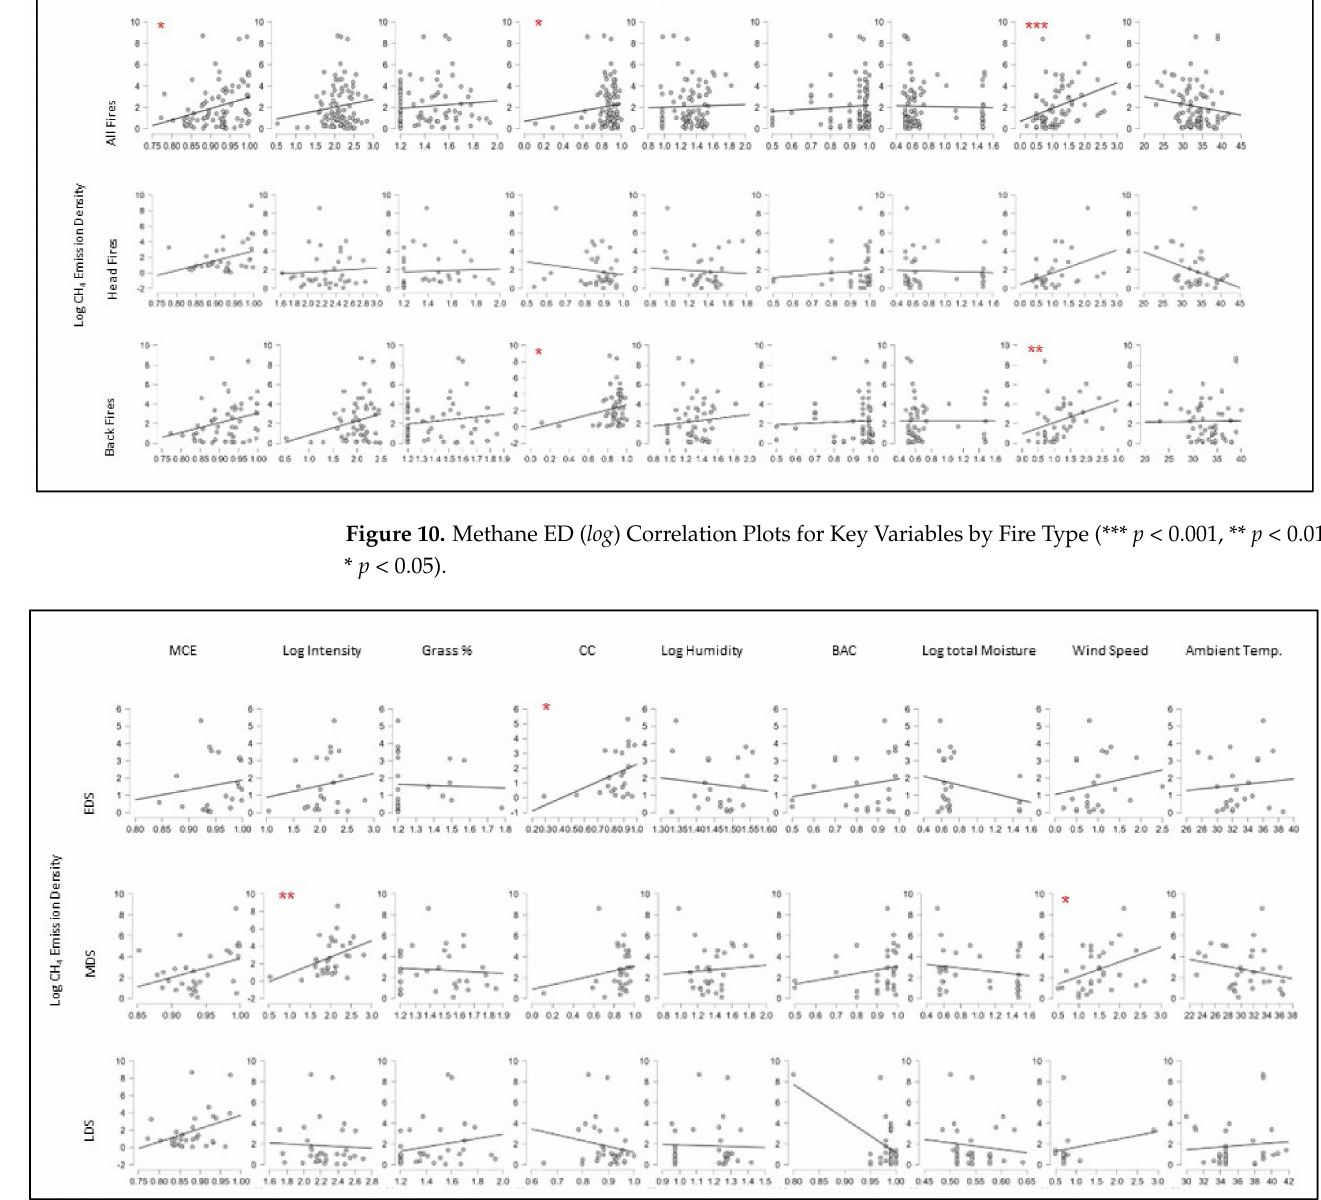
Figure 11. Methane ED ( log ) Correlation Plots for Key Variables by Fire Season (*** p < 0.001, ** p < 0.01, * p <